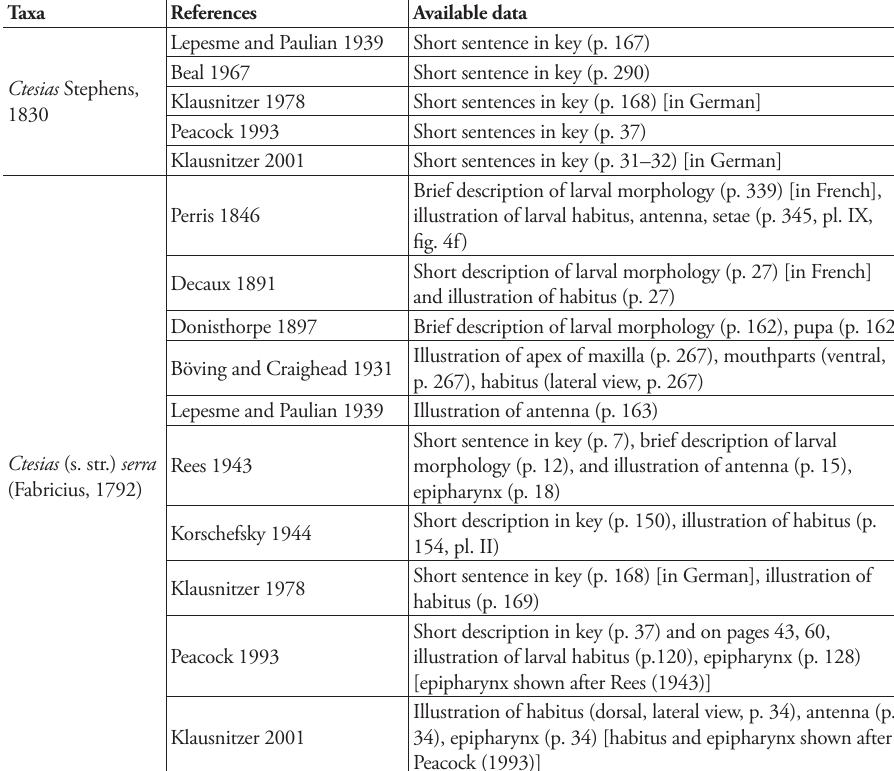
Table 1. List of Ctesias species with references related to larval morphological